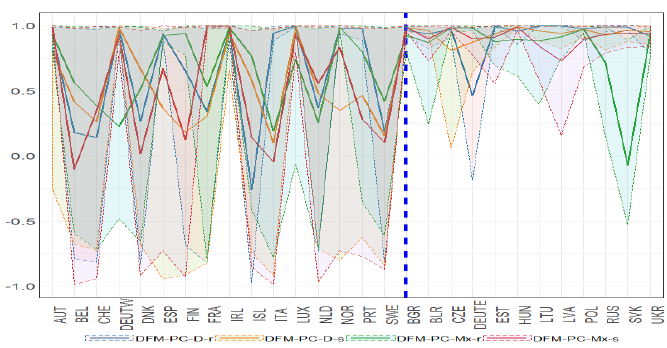
Figure 31. Bayesian posterior mean estimators with 95% posterior credible intervals for the estimation of the diagonal elements of the transition matrix Ω (x axis ) under DFM-PC-D-r, DFM-PC-D-s, DFM-PC-Mx-r and DFM-PC-Mx-s models (colours of lines). The dashed blue line divides the set of countries into developed (on the left side) and developing (on the right hand side) European countries, respectively.